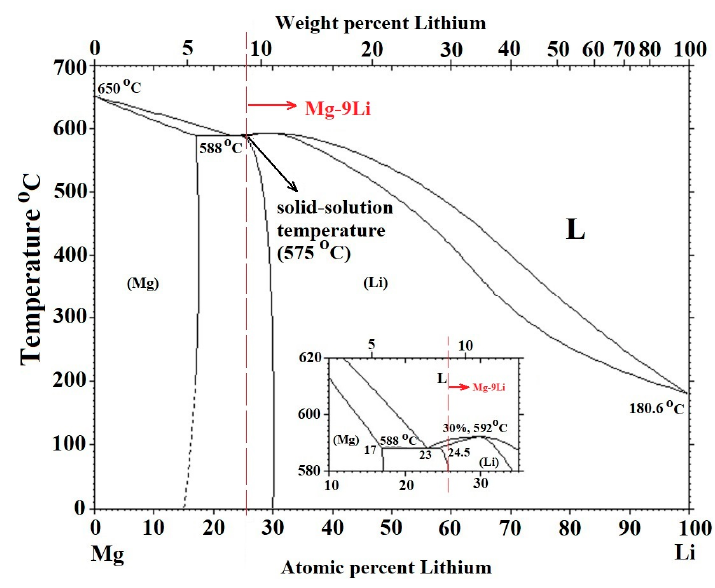
Figure 1. Binary phase diagram of the Mg-Li alloy [18].